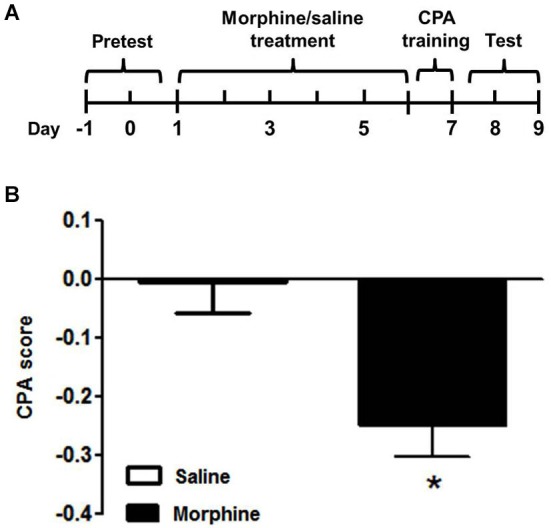
Naloxone-induced conditioned place aversion in morphine-dependent tree shrews. (A) Diagram outlining the behavioral procedures. (B) The morphine-dependent tree shrews exhibit place aversion to an environment previously paired with the withdrawal induced by naloxone, whereas the saline control group spent almost equal time in the two chambers. Blank and solid columns represent data from saline- and morphine-dependent tree shrews, respectively. The data are expressed as means ± SEM, n = 4–5. * p < 0.05, vs. the saline control group, t-test.